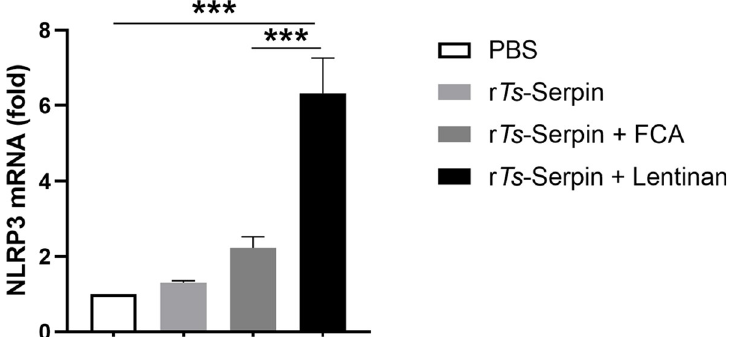
Fig 4. Expression of NLRP3 in CD4 + T cells. Results are relative to the expression at day 0. Results are the mean ± SD (n = 10) of three independent experiments. � p < 0.05, �� p < 0.01, ��� p < 0.001 as indicated by line (one-way ANOVA with Tukey’s